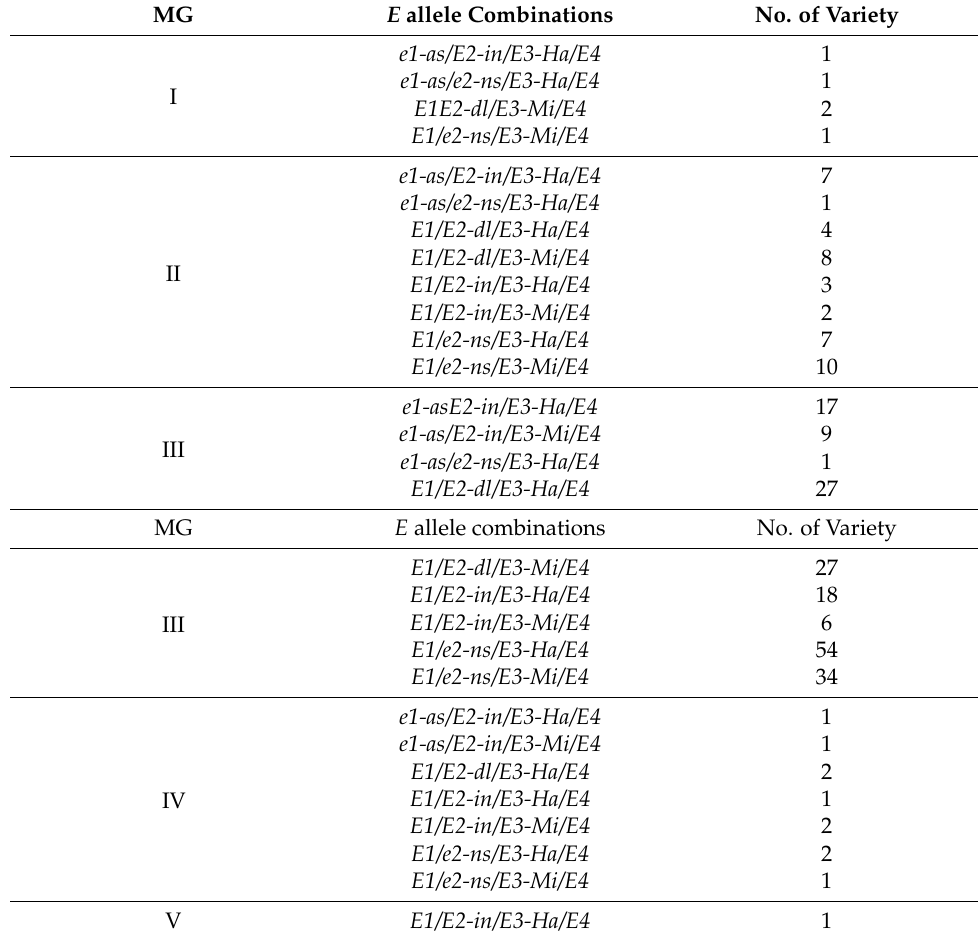
Table 1. The number of varieties with different E allelic combinations in different maturity groups (MG). MG